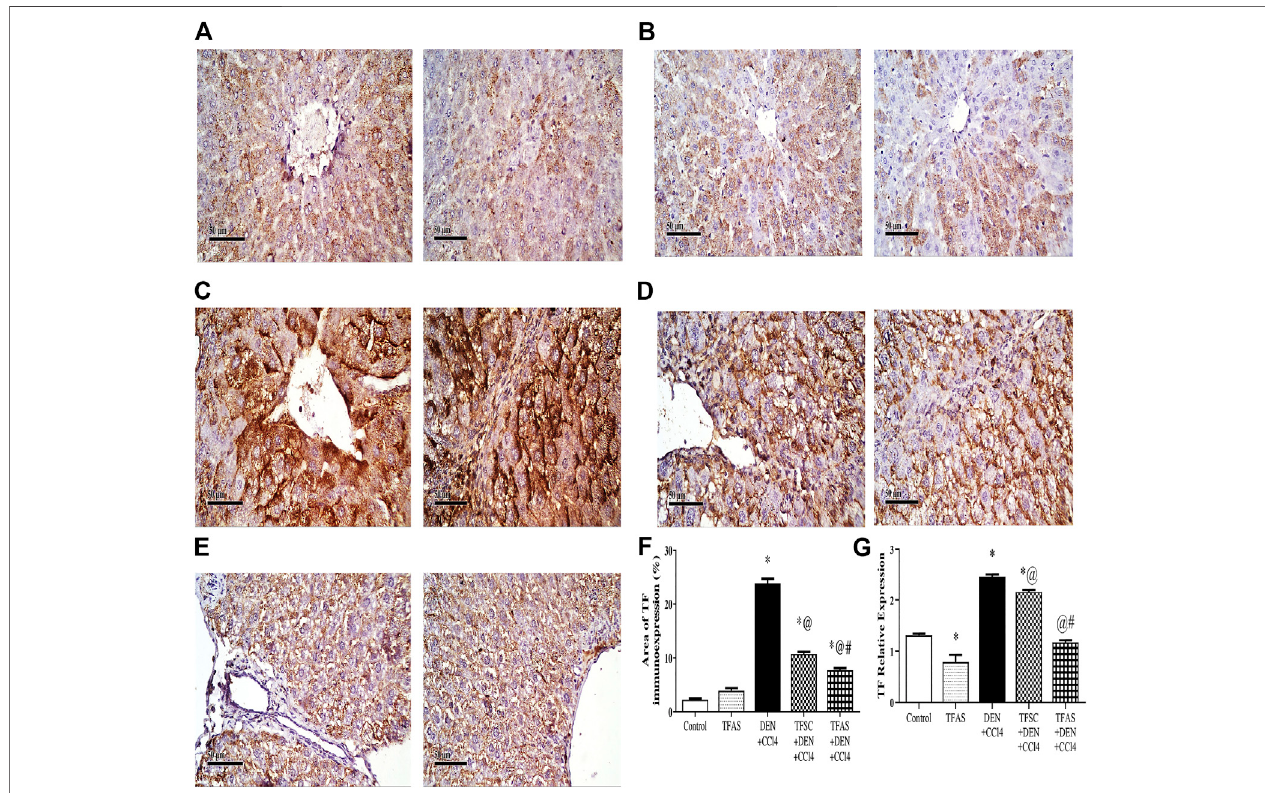
FIGURE1| EffectofTF-ODNs ontheliver TFexpression inDEN+CCl4intoxicatedrats. Immune-stained liversection ofTFexpression withpositivestainedgrades of cytoplasmic and sub membranous positivity in numerous hepatocytes, (A) control group, (B) TFAS group, (C) DEN+CCl4 group, (D) TFSC+DEN+CCl4 group, (E) TFAS+DEN+CCl4 group and (F) The percentage area of TF immune-expression and (G) qPCR determined TF expression in all study groups. Data are expressed as mean ± SEM (n (cid:1) 8). (*), (@) and (#) indicate signi fi cant difference from Control, DEN+CCl4 and TFSC+DEN+CCl4, respectively at P < 0.05 using one-way ANOVA followed by Tukey-Kramer post-Hoc test. TF: tissue factor; DEN: N-diethyl nitrosamine; CCl4: carbon tetrachloride; TFSC: scrambled tissue factor oligodeoxynucleotides; TFAS: antisense tissue factor